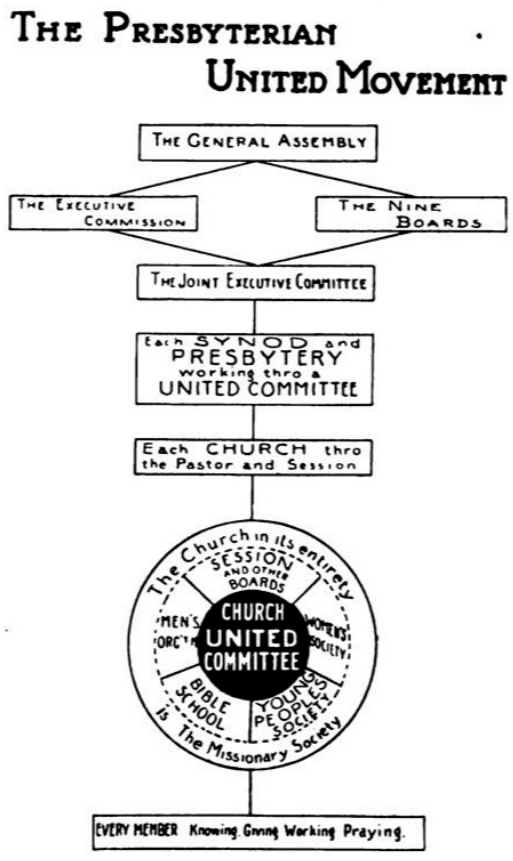
Figure 1. Presbyterian United Movement chart. The chart was meant to clarify the relationship between parishioners, benevolences, and the church hierarchy. This structure appealed to the Board of Foreign Mission’s desire for every member to give, but the Board expressed concerns that missions would lose its particular appeal to parishioners. Source: Assembly Herald 20, no. 1 (January 1914): 7.